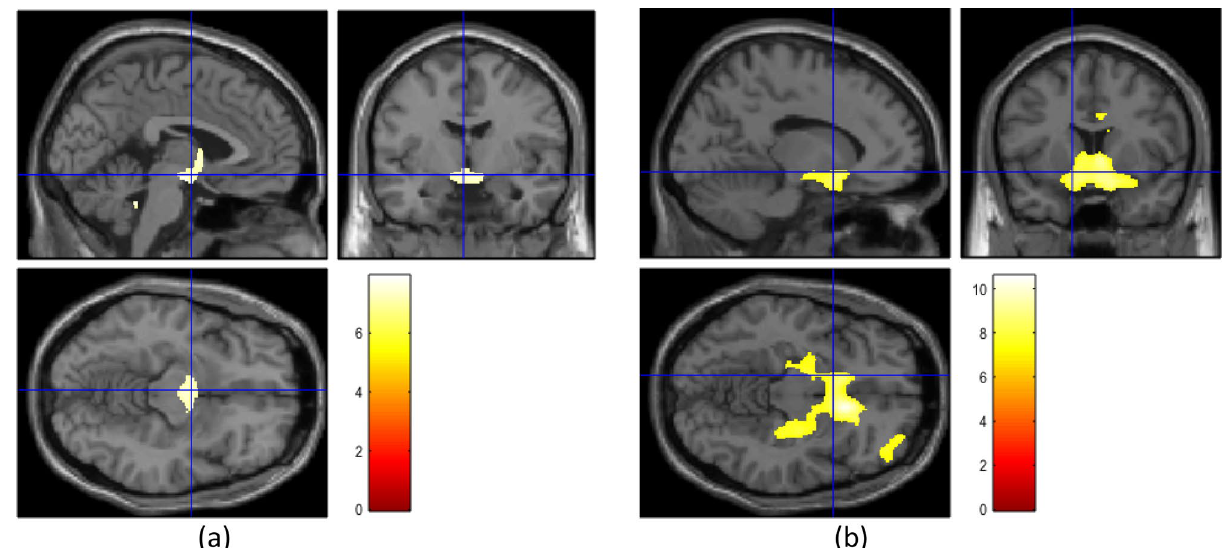
Figure 1. Voxel based morphometry analysis results indicating regions where structural changes between the groups were found using the contrast gray matter in the group 1 > gray matter in the group 2. ( a ) When